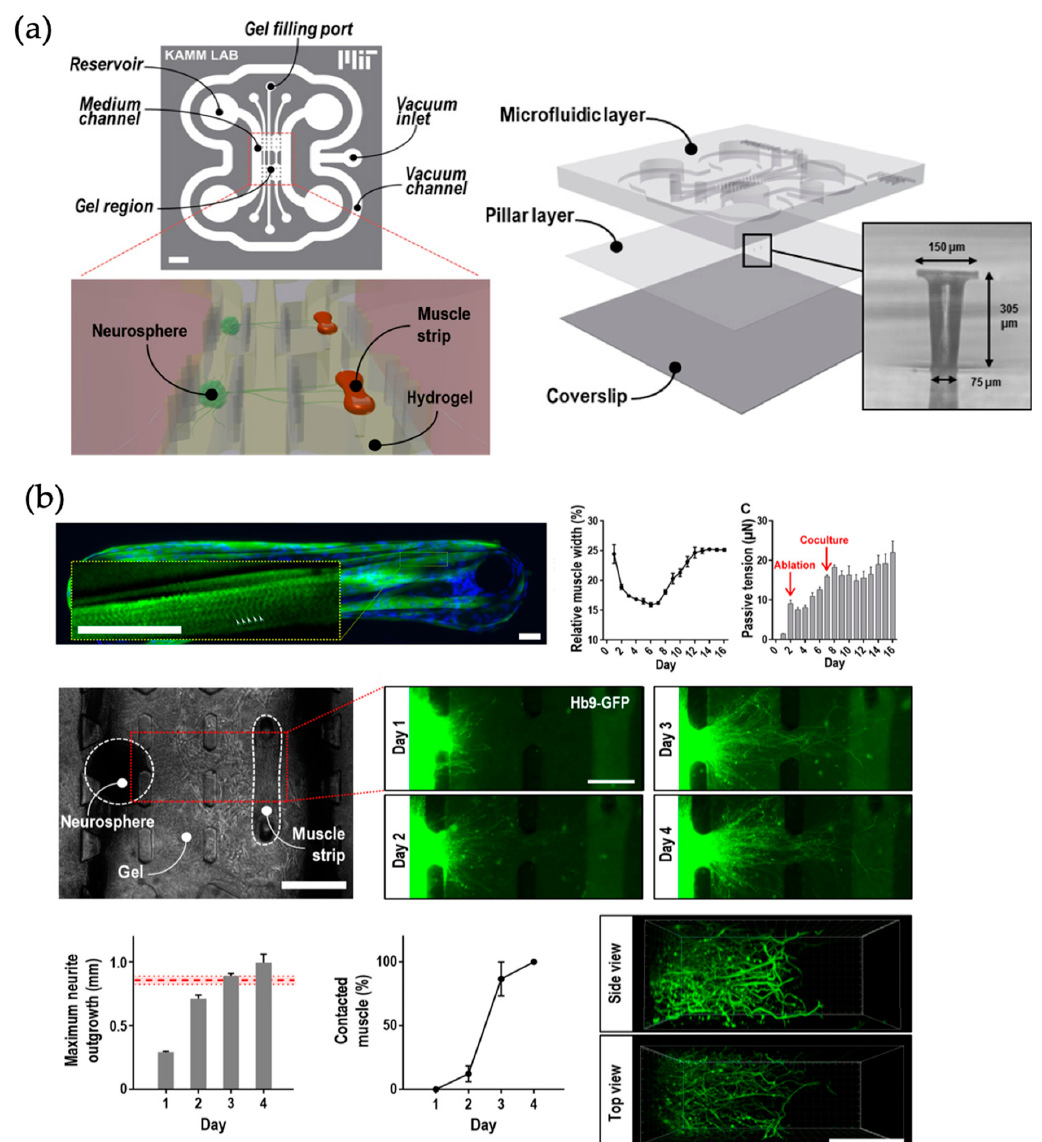
Figure 8. ( a ) Microfluidic device temporarily bonded by vacuum and composed of two layers: (I) Microfluidic layer and (II) PDMS membrane featuring two sets of two capped pillars measuring muscle deflection. ( b ) Muscle and neurite growth over 16 days and muscle contraction measurement. (Reprinted from [61] with permission from